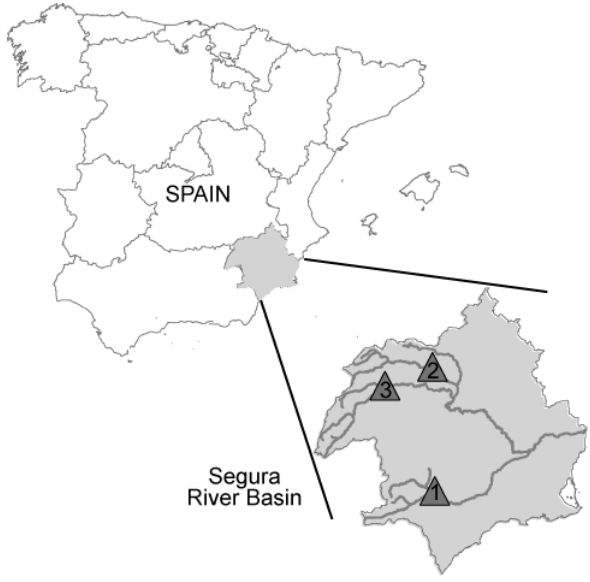
Figure 5 . Single reservoir systems analysed (case studies). Location map 787 Fig. 5. Single reservoir systems analysed (case studies). Location